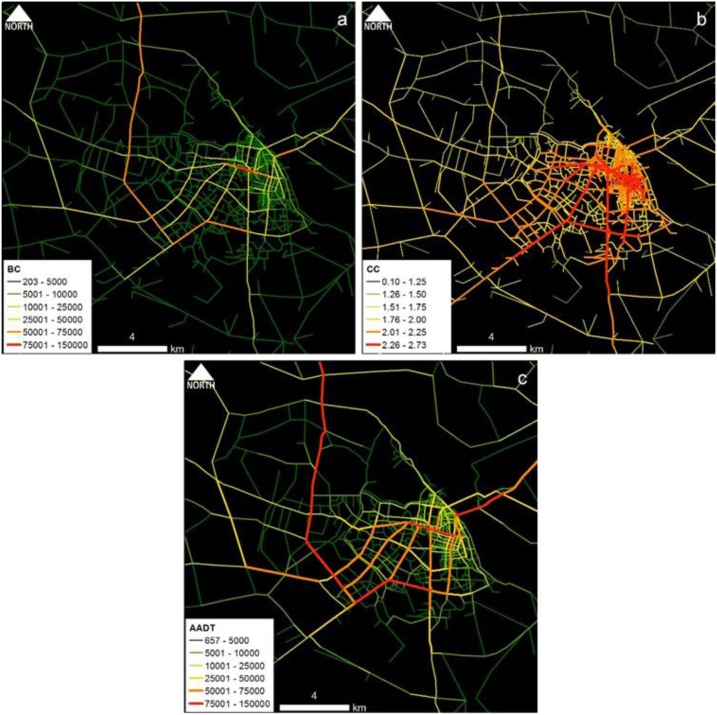
Hanoi case study area: Spatial distribution of (a) BC(PD) and (b) CC(PD) and (c) estimated AADT.